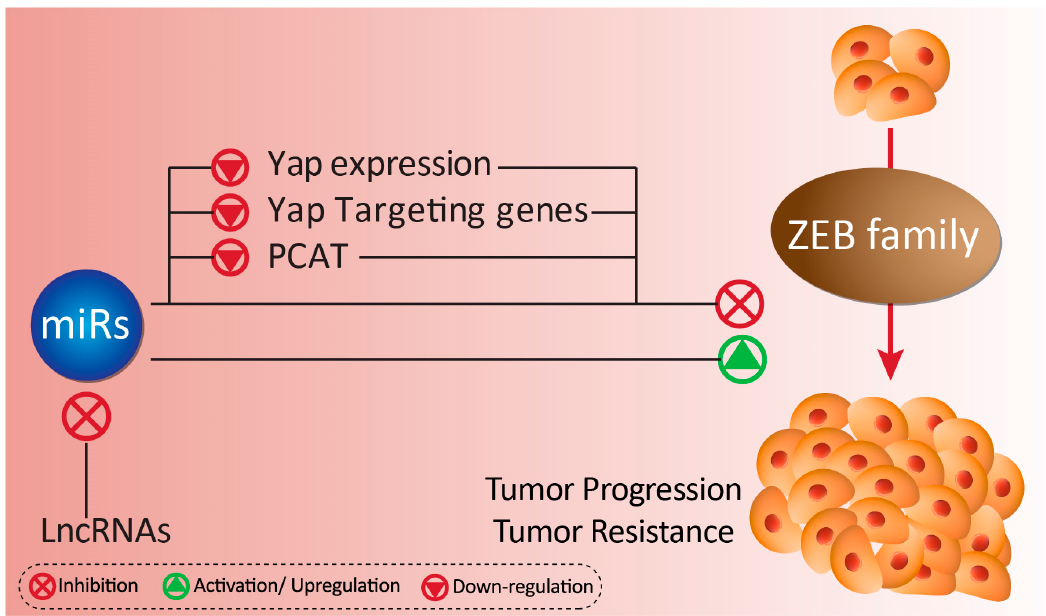
Figure 3. The miRs as key player in regulation of tumor malignancy via targeting ZEB proteins.